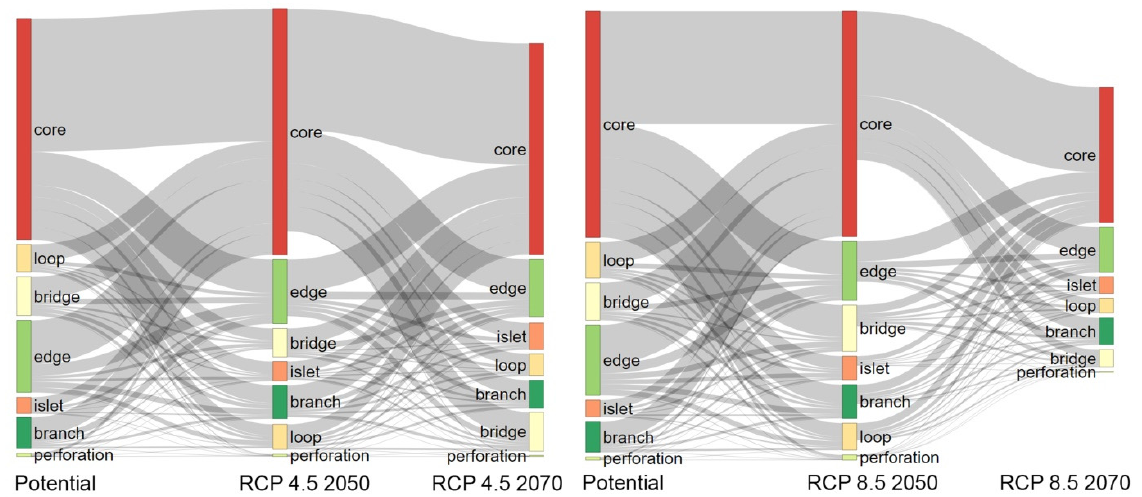
Figure 4. Sankey diagrams showing the transitions between the main structural elements according to the morphological spatial pattern